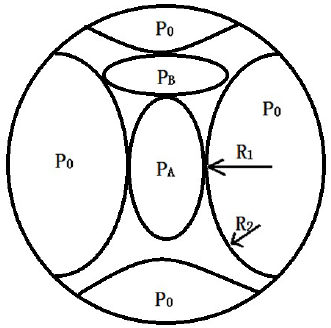
Figure 8. Schematic diagram of liquid film drainage